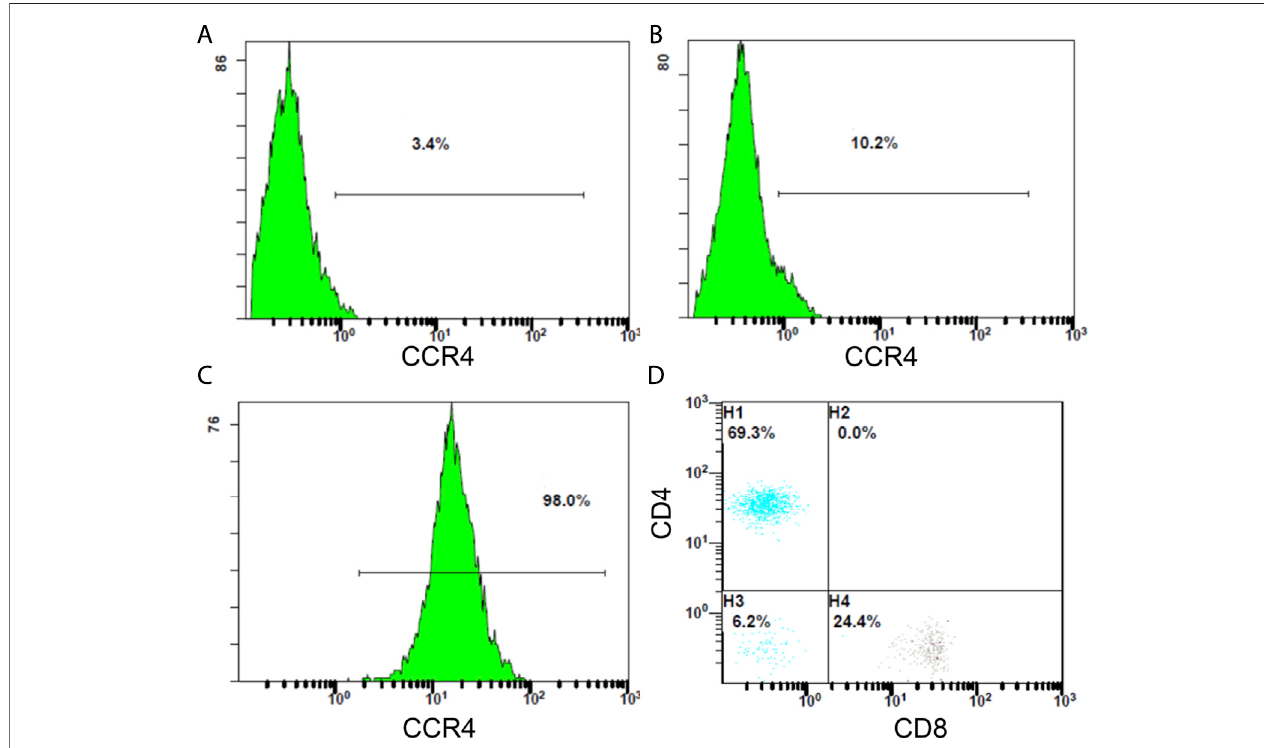
FIGURE14|(A) ProportionofCCR4-positivelymphocytesinPBMCbeforetumorantigenstimulation. (B) ProportionofCCR4-positivelymphocytesinPBMCafter tumor antigen stimulation. (C) Flow sorting puri fi cation results of CCR4-positive lymphocytes. (D) Proportion of CD4-positive and CD8-positive cells in CCR4-positive